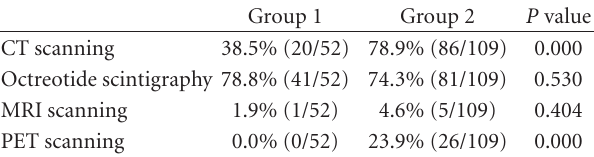
Table 3: Imaging modalities performed at referral.